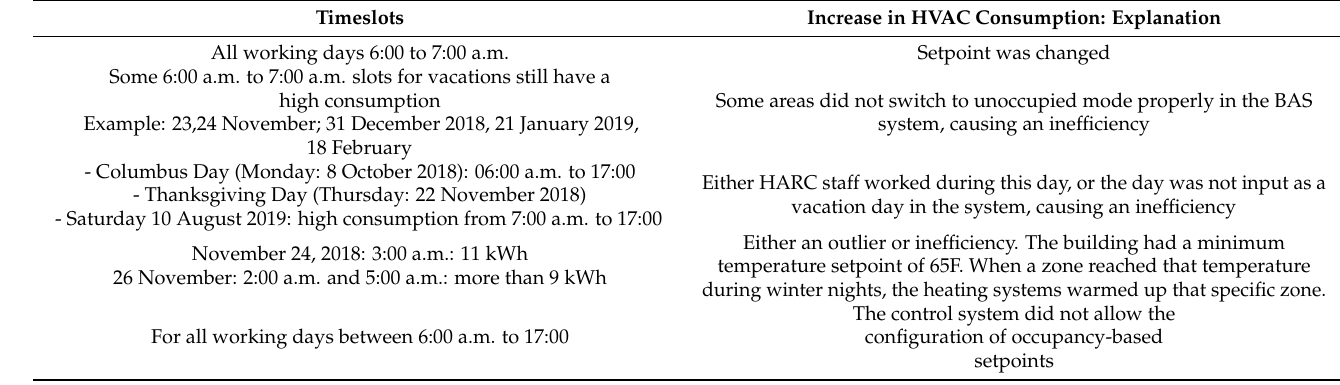
Table 10. Identifying the timeslots with